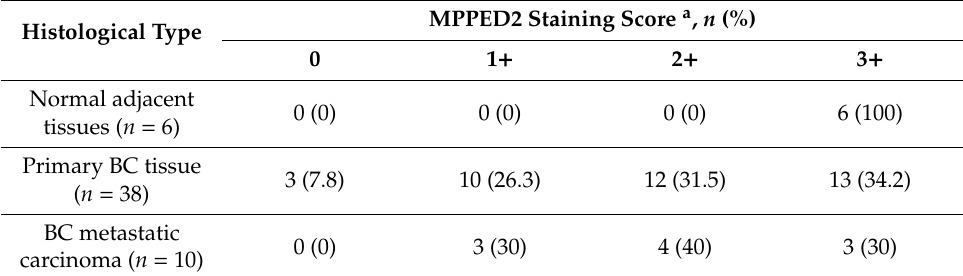
Table 1. MPPED2 protein expression evaluated by immunohistochemistry in breast cancer (BC) Histological